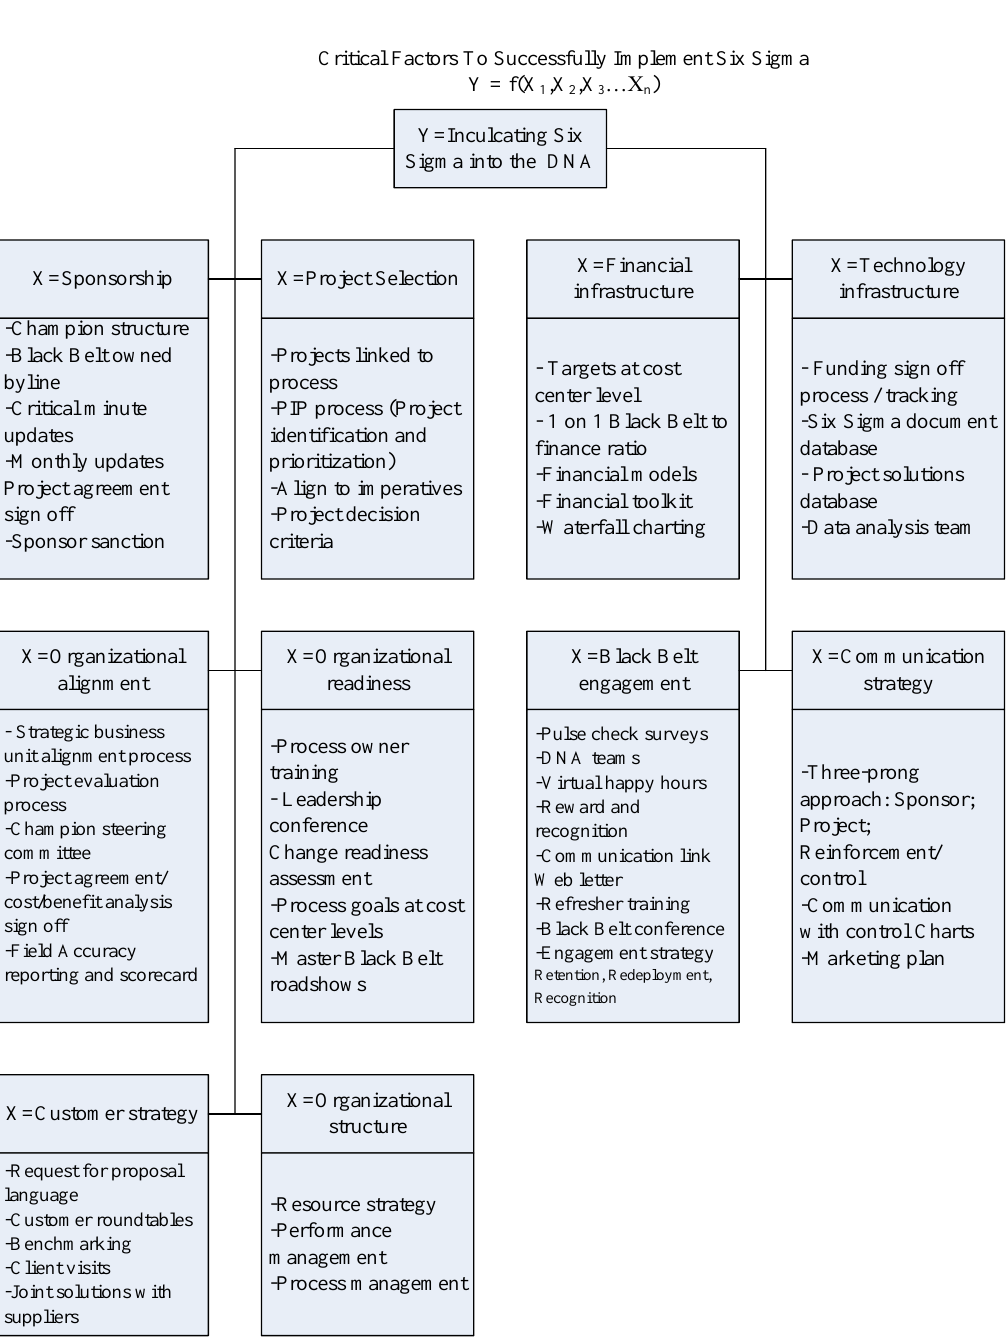
Fig. 5. Six Sigma implementation key success factors (Young,